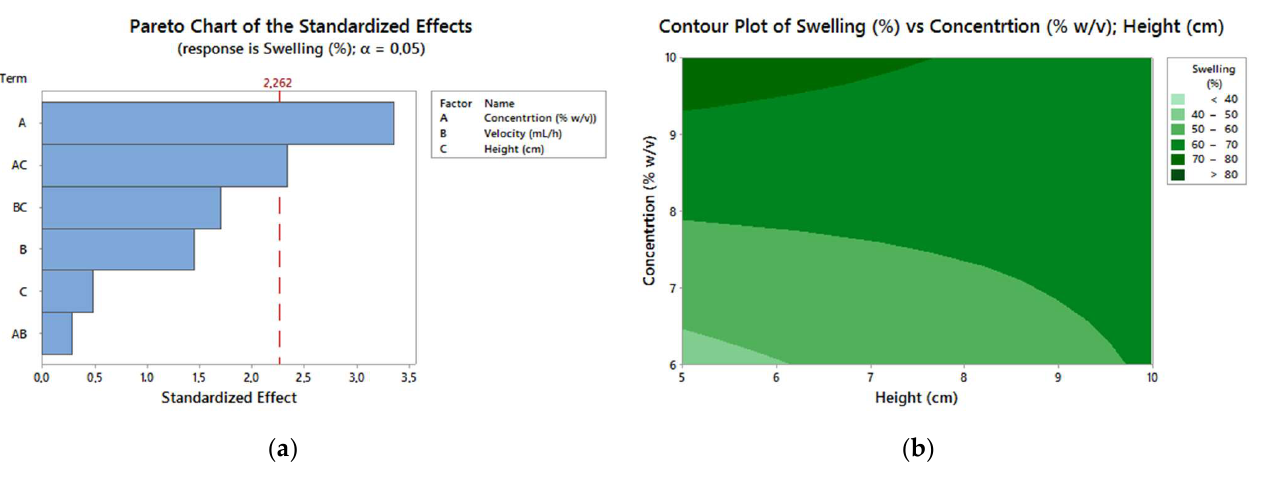
Smaller swelling values were observed in the samples S 1 -6-20-5 S 3 -6-30-5, S 7 -6-30-10, S 9 -6-20-5, and S 11 -6-30-5, and the samples S 2 -10-20-5, S 4 -10-30-5, S 8 -10-30-10, S 10 -10-20-5,